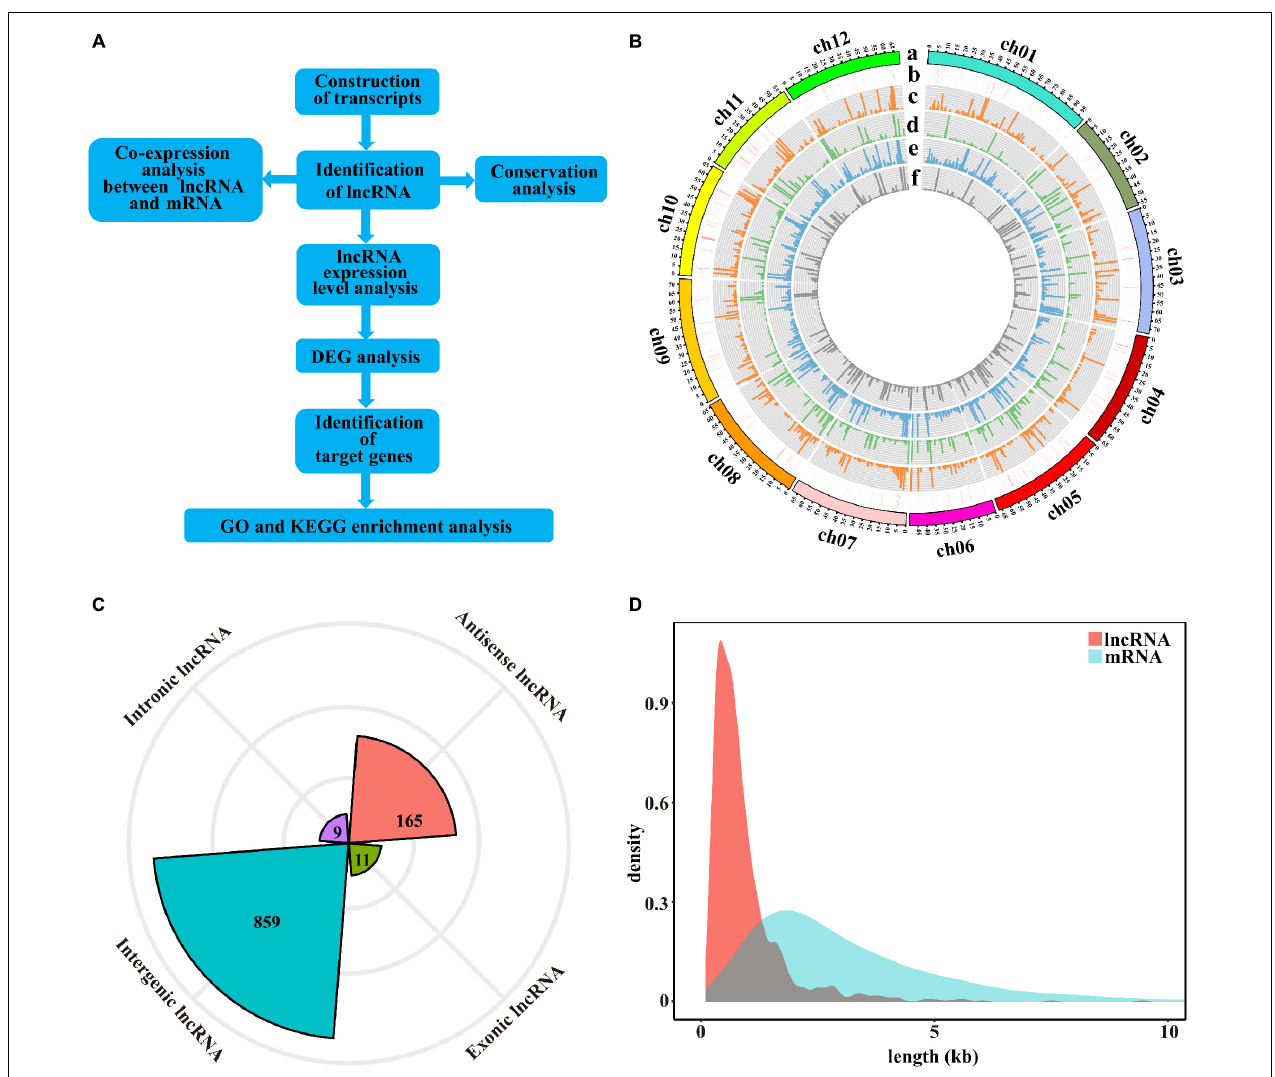
FIGURE 1 | Identification and characterization of lncRNAs in tomatoes. (A) The pipeline for the identification of lncRNAs in tomatoes. (B) Circos plot depicting the distribution and expression of identified lncRNAs. From outer to inner circles, a–f circles represent chromosomes, lncRNAs distribution on chromosomes, the expression levels of lncRNAs in the control sample of M82, the expression levels of lncRNAs in the control sample of Solanum pennellii ( S. pennellii ), the expression levels of lncRNAs in the salt-treated sample of M82, the expression levels of lncRNAs in the salt-treated sample of S. pennellii , respectively. The vertical lines represent the high-low values of lncRNAs. (C) Radar chart represents the numbers of the four lncRNA types. (D) Length distribution of lncRNAs and mRNAs, orange represents lncRNAs, blue represents